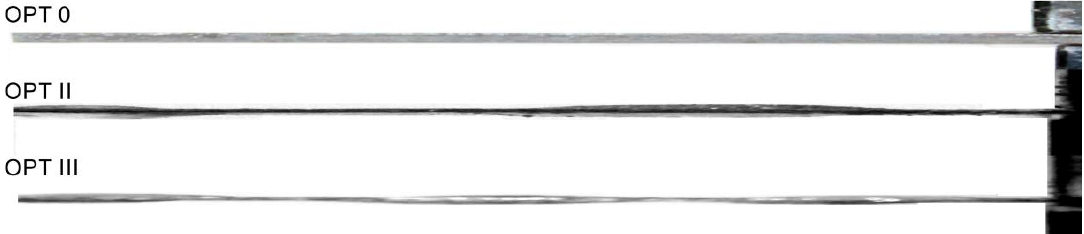
Figure 3. Photos of experimentally tested microcantilevers of three different configurations: OPT 0; OPT II and OPT III.